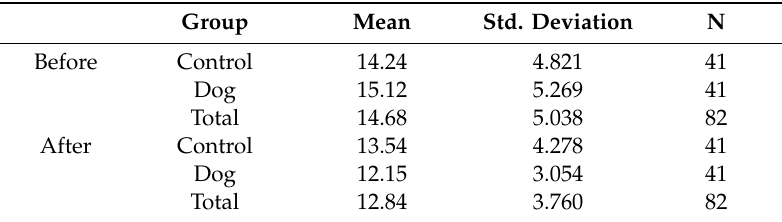
Table 2. Descriptive Statistics: Negative A ff